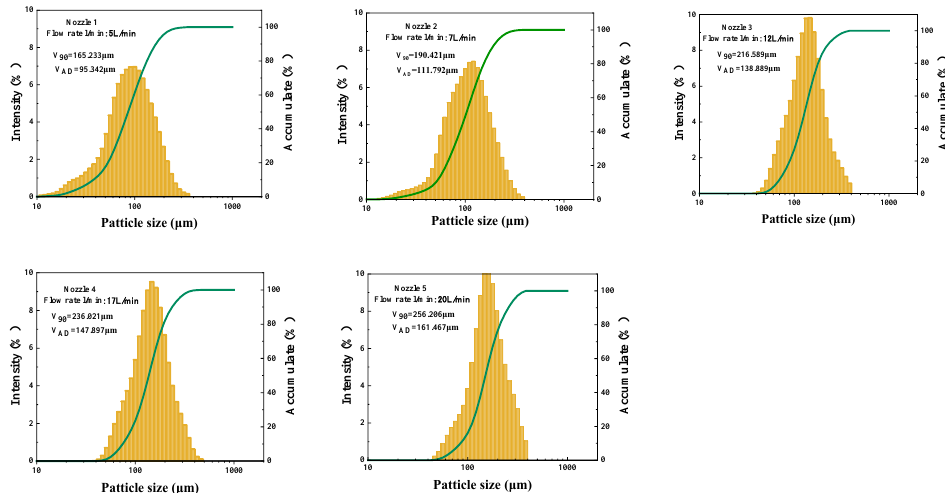
Figure 3. Patticle size distribution of water droplets under different nozzles.